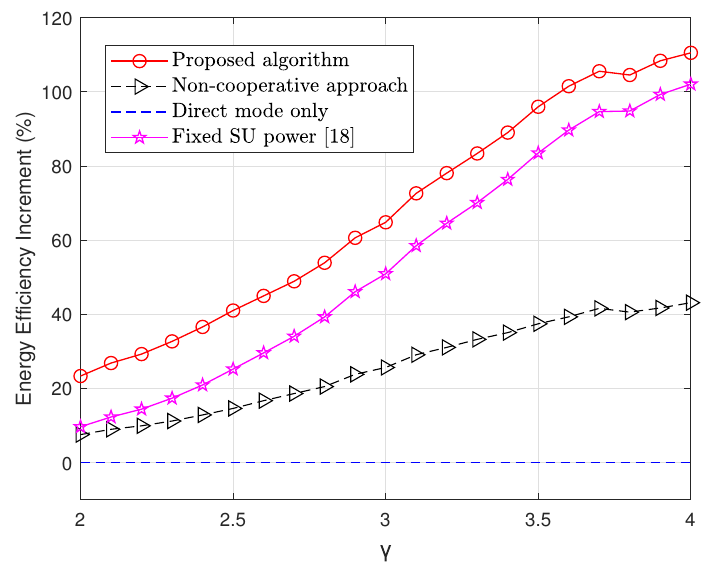
Figure 6. Energy efficiency increment with respect to direct mode varying the path loss exponent. M and K change randomly from 1 to 15 while σ s = 8dB.